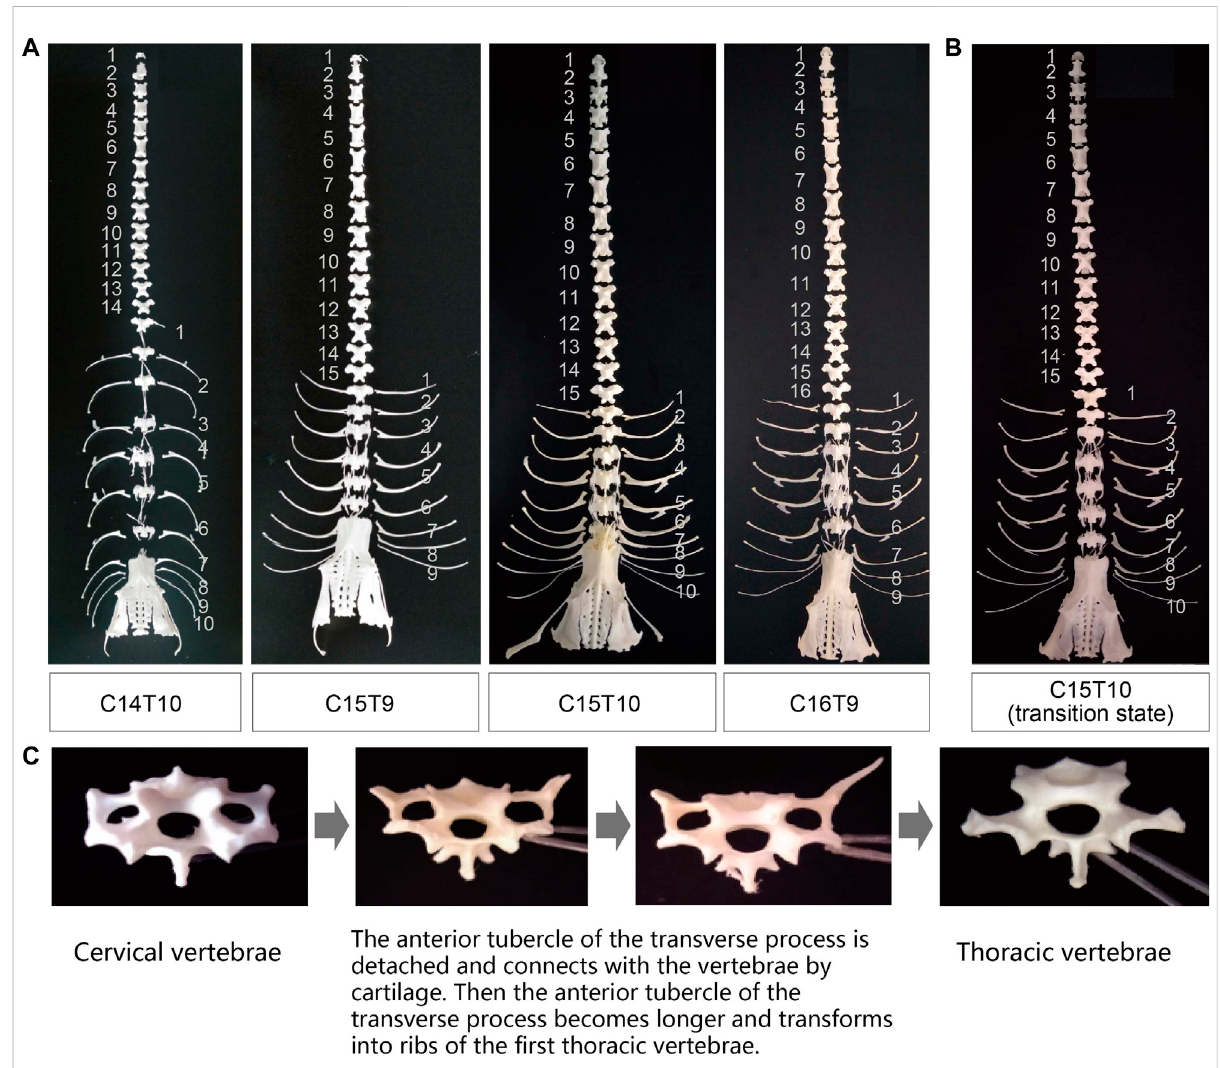
FIGURE 1 Phenotypic variation in the number of cervical and thoracic vertebrae in ducks. (A) Specimens of duck axial skeletons with C14T10, C15T9, C15T10, andC16T9. Cmeansthenumberof cervicalvertebrae;Tmeansthenumberofthoracicvertebrae. (B) Specimensand X-ray photography of the duck axial skeleton with C15T10 (15 cervical vertebrae and 10 thoracic vertebrae) in the transitional state with extremely short fi rst ribs. (C) Morphological transition from the last cervical vertebra to the fi rst thoracic